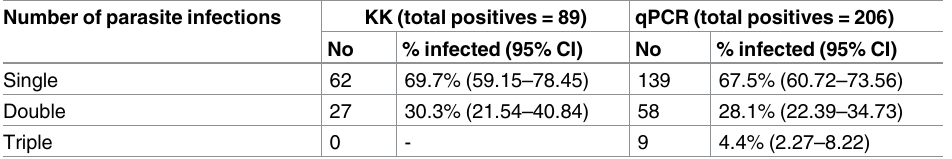
Table 7. Distribution of single, double and triple STH infections among schoolchildren from selected elementary schools in Laguna province, Philippines positive for at least one STH infection by KK and